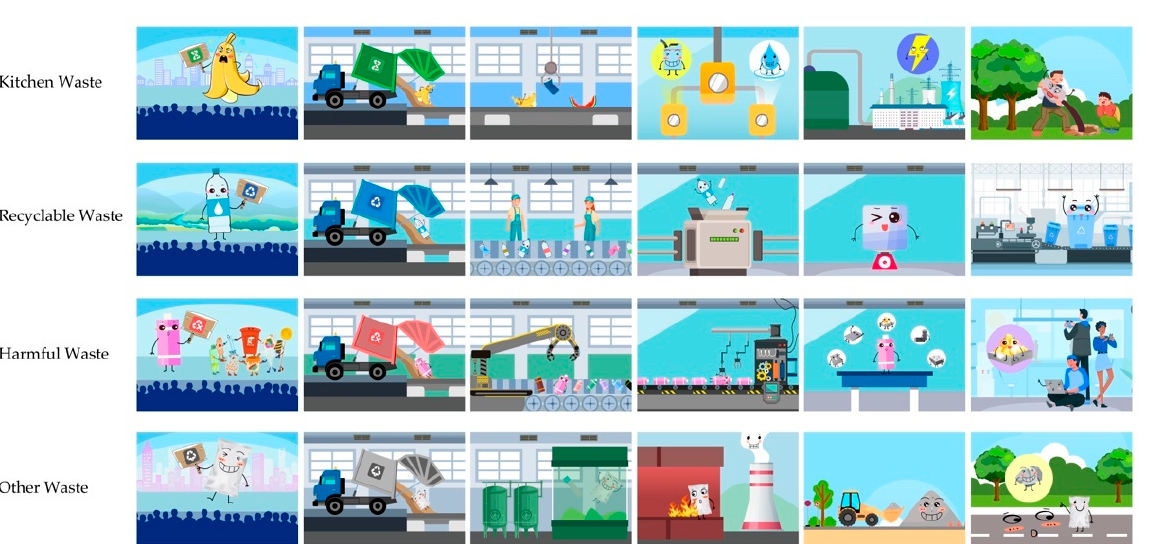
Figure 4. Expressive reactions of the designed intelligent trash can system toy. The toy displayed different expressions to distinguish whether users threw the garbage into the wrong trash can or not ( a ). The garbage thrown in the trash was displayed in the form of cute cartoons on the monitor ( b ). (Figure 5).